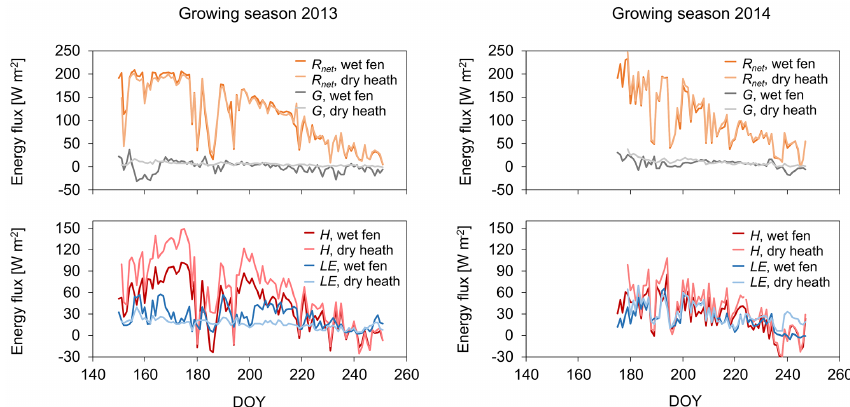
Figure 6. Growing season energy fluxes. Mean daily net radiation ( R net ), sensible heat flux ( H ), latent heat flux (LE) and ground heat flux ( G ) at the wet fen and dry heath during the growing seasons in 2013 (left panels) and 2014 (right panels).